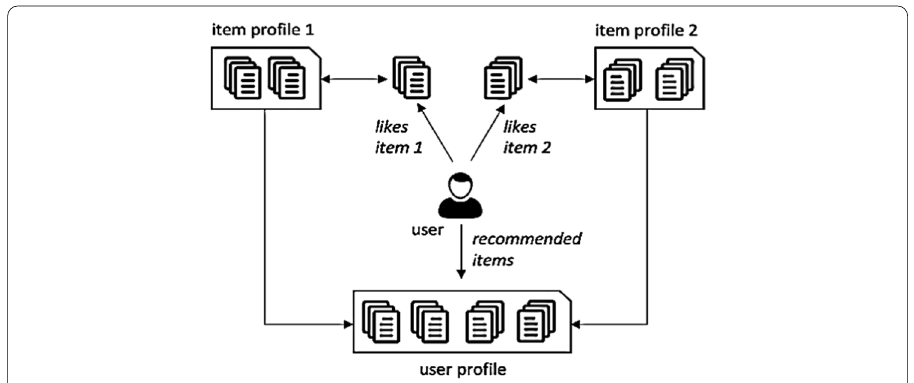
Fig. 2 Content-based recommender